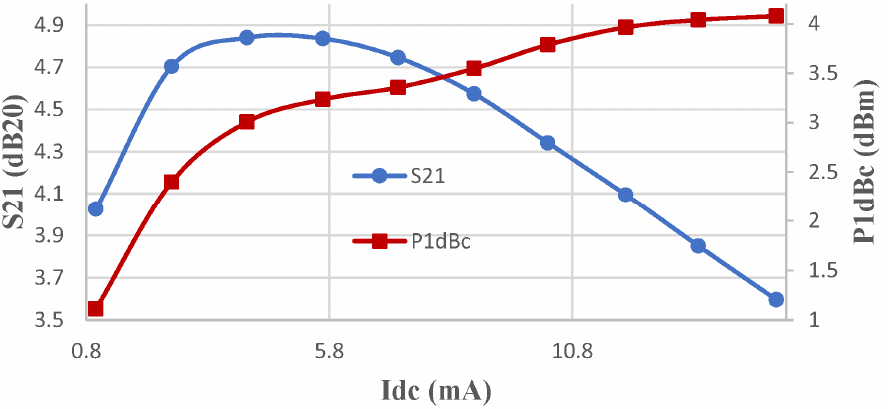
Figure 7. Gain and Input P1dB versus DC current source.